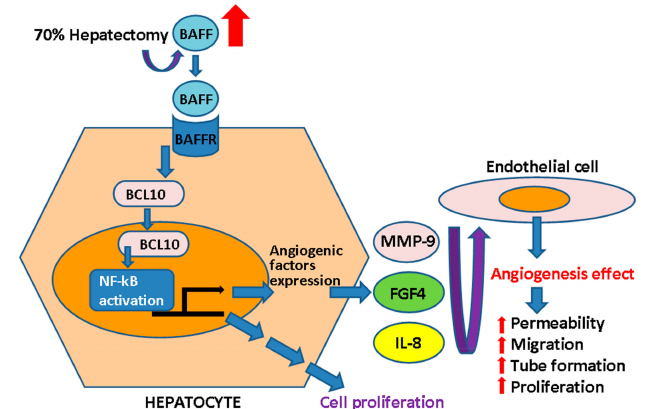
Figure 6. Summary of BAFF in liver regeneration. In this study, we found that BAFF was induced in the remaining liver tissue after 70% partial hepatectomy. Since BAFFR was found to be expressed in hepatocytes, we assumed the BAFF activated BCL10 nuclear translocation through BAFFR. BCL10 nuclear translocation subsequently activated NF- κ B-dependent gene expression, including cell proliferation, as consistent with a previous study. 11 Interestingly, we found that BAFF may enhance the expression of factors that promote gap formation, permeability changes, migration, tube formation on matrix gel, and endothelial cell proliferation. Moreover, we found the BAFF / BCL10 / NF- κ B cascade activated the angiogenesis-related factors MMP-9, FGF4, and IL-8. The results demonstrated that BAFF expression was critically involved in hepatocyte-driven angiogenesis during liver